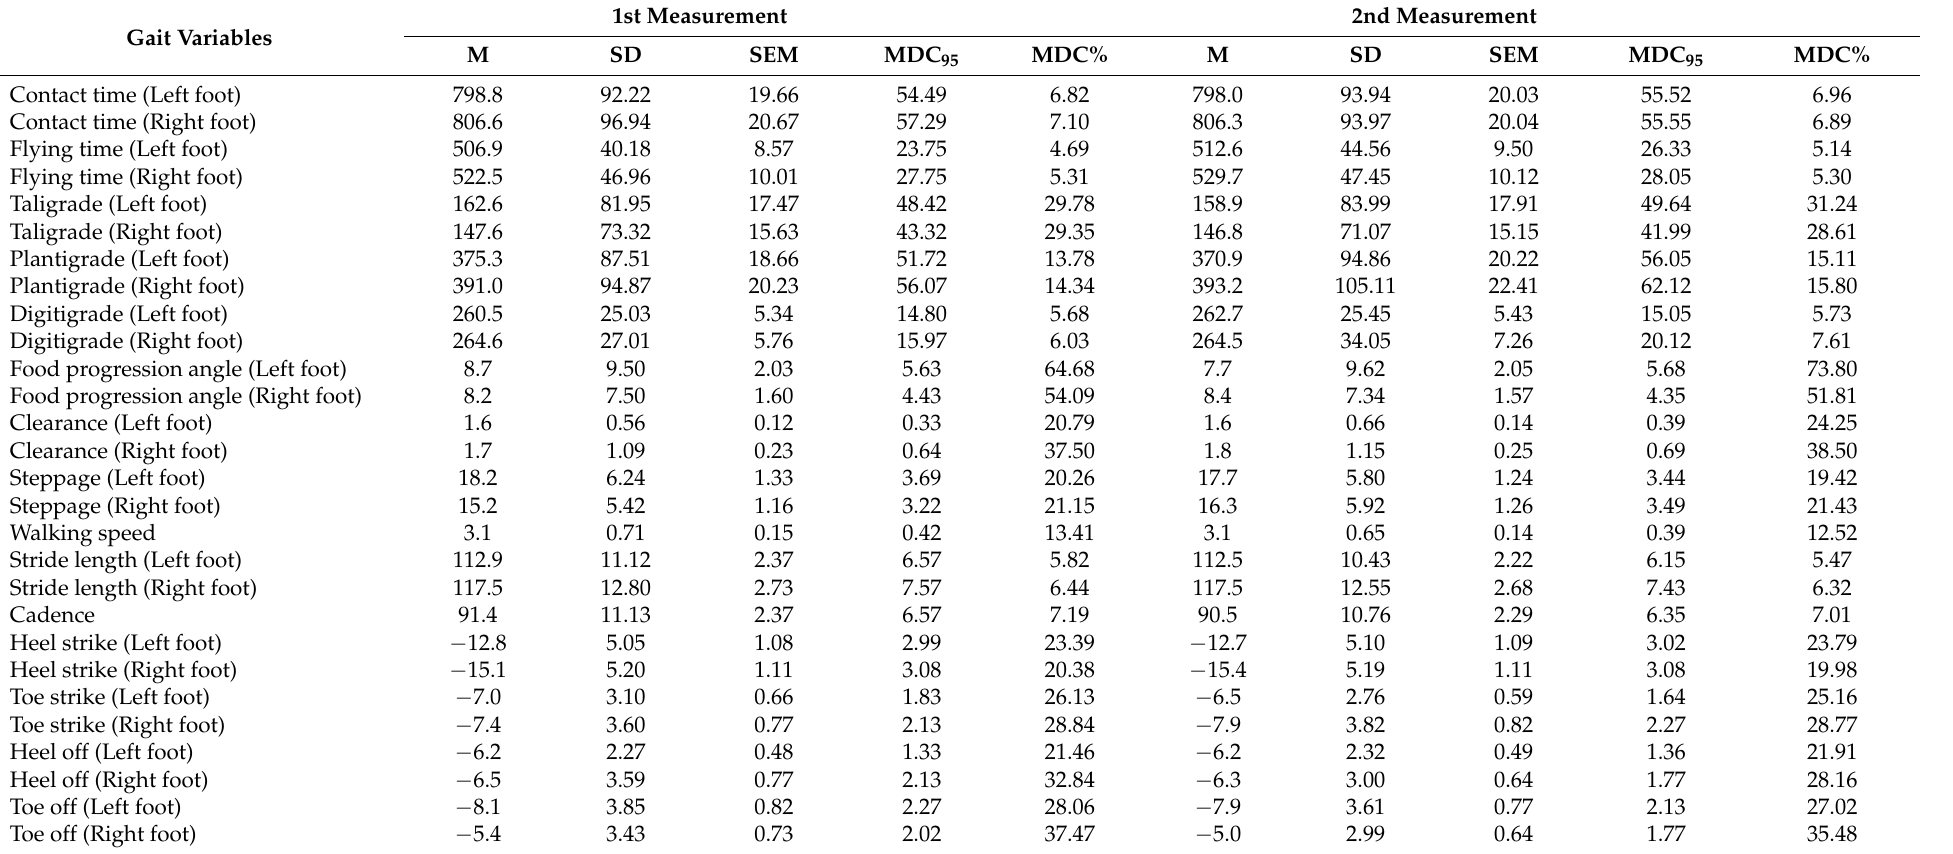
Table 2. Descriptive statistics concerning PODOSmart ® gait variables between the two